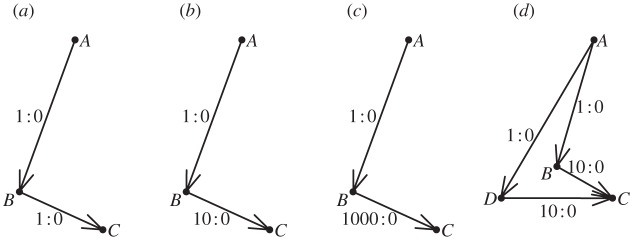
Examples of dominance paths of order 1. Dominance paths from node A to C through intermediate nodes B and D, with win–loss ratios.